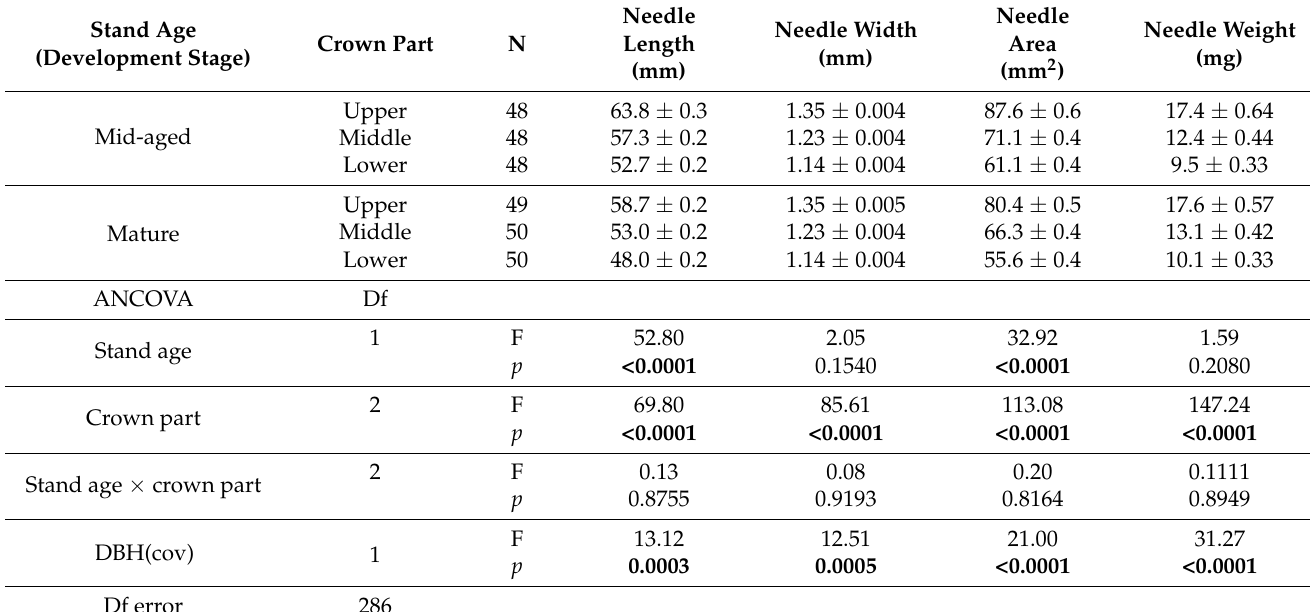
Table 2. Means ( ± standard error) of the needle parameters of Scots pine sample trees with ANCOVA results. Statistically significant differences at p < 0.05 are shown in